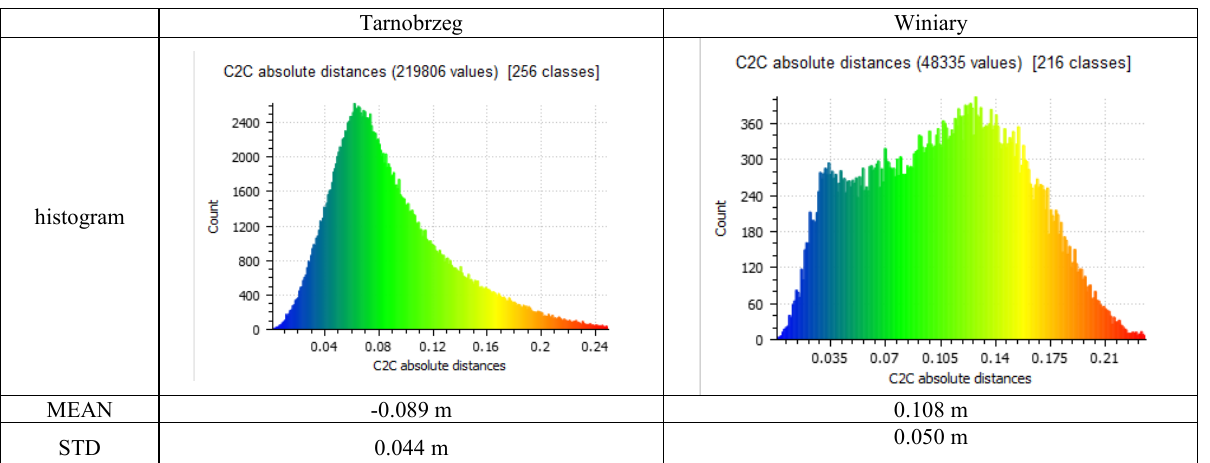
Table 7. ULS-DIM differences for a flat area (asphalt road near levee)